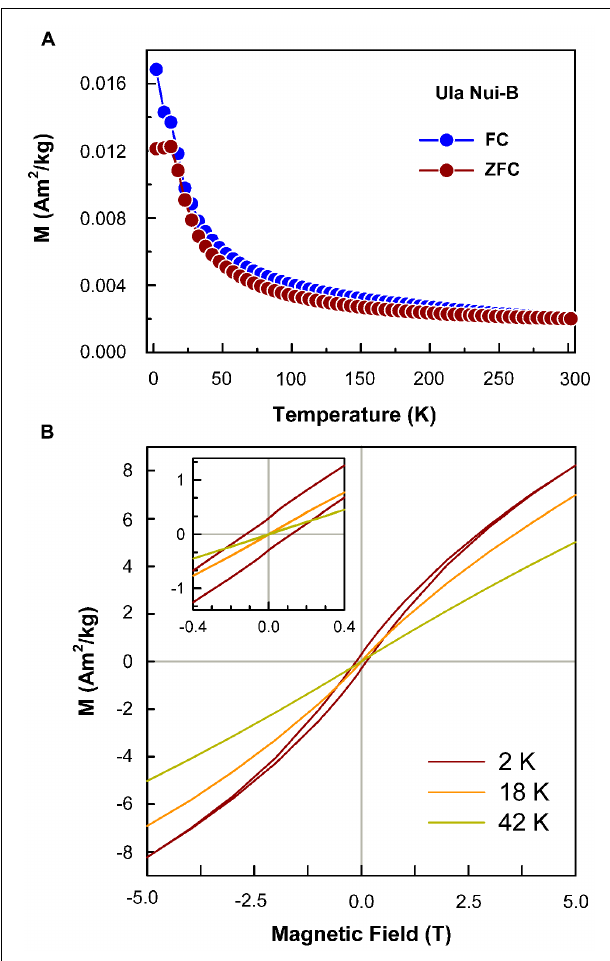
FIGURE 7 | Induced magnetization curves, ZFC/FC and hysteresis loops. (A) ZFC/FC curves typical of Loihi Fe mat samples. Above peak temperature the material behaves as a paramagnetic phase. Below the peak temperature the material has magnetic order. (B) The Hysteresis loops at variable temperature show the antiferromagnetic character of ferrihydrite, that is the non-saturation at high fields. At 2K the coercive force is different of zero (see inset) and indicates the sample has magnetic order. At 18 and 42K H C is zero and indicates the sample is in the superparamagnetic state.